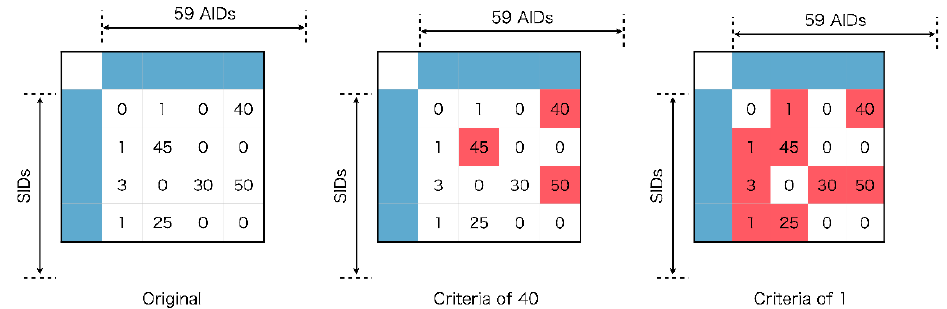
Figure 7. Relationship between the thresholds and active / inactive judgment. Red and white squares mean active and inactive judgments, respectively. Blue square means AIDs and SIDs.